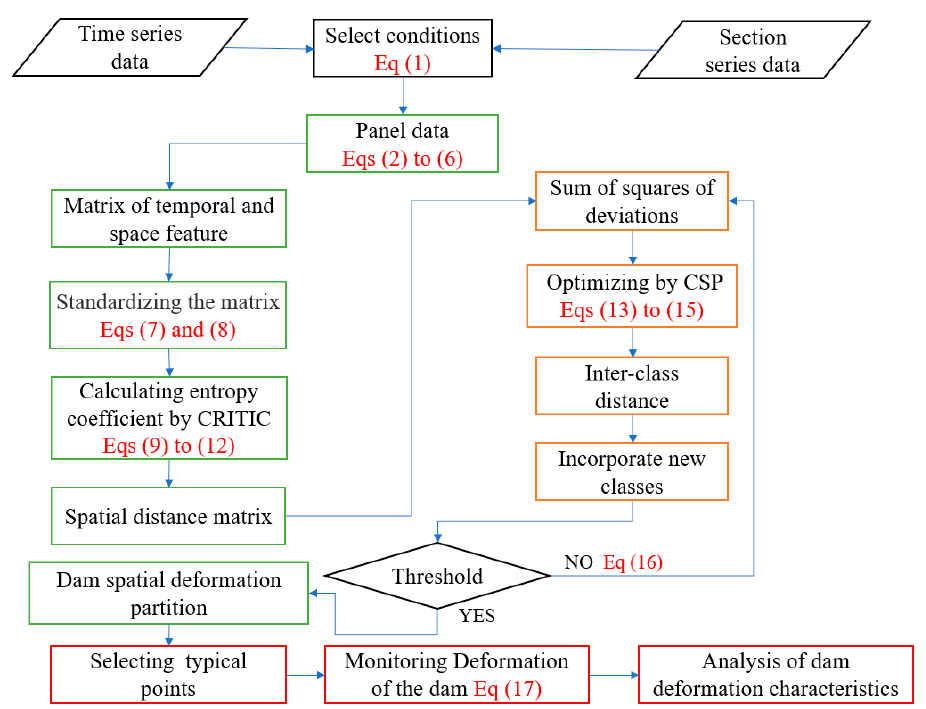
Figure 1. Flow chart of the deformation zoning and monitoring model of an ultra-high arch dam operating at a complex water level.